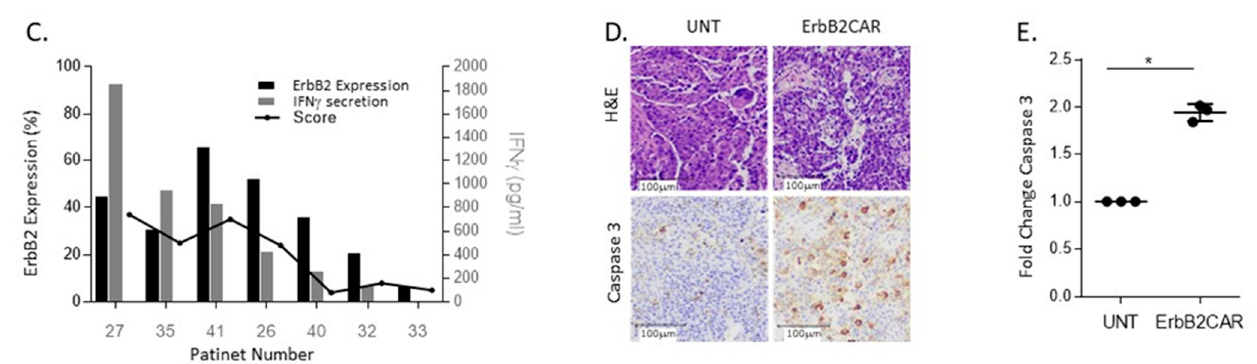
Figure 4. ErbB2CAR specifically promotes killing of primary ovarian tissues. Tissues were col- lected from patients with HGSOC before and after neoadjuvant treatment and signal cell suspension was stained with anti-human ErbB2-APC. mIgG1-APC was used for isotype control. The cells were analyzed by flow cytometry. ( A ) A representative flow cytometric analysis of samples from patients before neoadjuvant treatment ( left ) and after neoadjuvant treatment ( right ). ( B ) Summary of ErbB2 expression in 24 patients before neoadjuvant and 5 patients after neoadjuvant as analyzed by flow cytometry. Data were analyzed by Student’s t -test before versus after neoadjuvant treatment * p < 0.05. ( C ) Seven tissues were randomly selected for further analysis by cResponse TM . Single cells were stained for anti-human ErbB2 expression determined by flow cytometry (black bars). Histological sections were co-cultured for 72 h with ErbB2CAR or UNT cells. Supernatants were collected and analyzed for IFN γ secretion as determined by ELISA (gray bars), and H and E staining determined tissue viability after treatment. The score was calculated as described in Materials and methods. The viability of the cancer cells was calculated as the delta score of ErbB2CAR treatment and of UNT treatment (black line). ( D ) Representative staining with H&E (top panel) and cleaved Caspase 3 (bottom panel) of HGSOC tissue after co ‐ culture with ErbB2CAR or UNT cells for 72 h. ( E ) Fold change in cleaved Caspase 3-positive cells as calculated from the average of four areas in each tissue. UNT treatment was considered as 1. The displayed results are the average of three tissues ± STDEV. Data were analyzed by Student’s t -test ErbB2CAR versus UNT treatment * p <